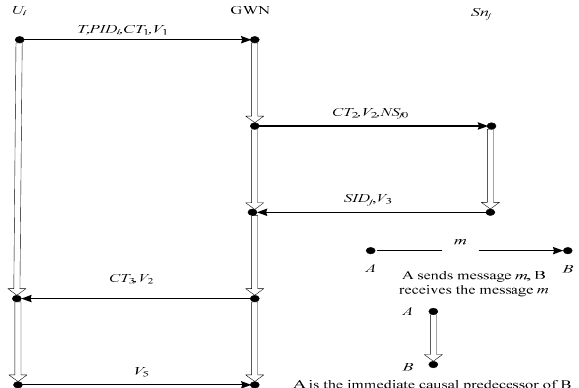
Figure 6. LAAP strands space model.